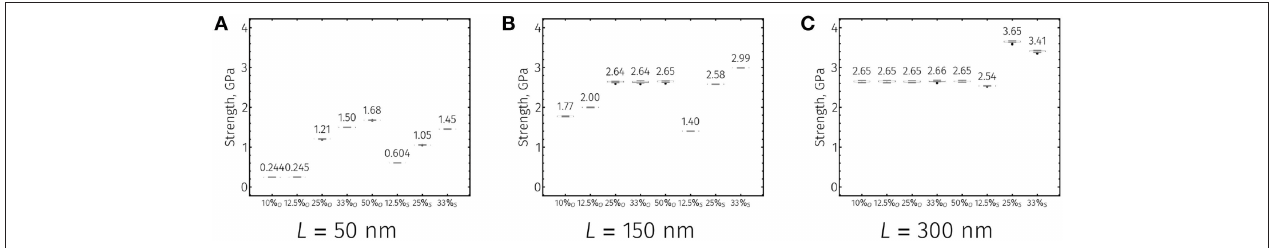
FIGURE 6 | Strength box-whisker plots (20 independent simulations for each structure) of CNC films with approximate base fiber lengths (A) L = 50nm, (B) L = 150nm, and (C) L = 300nm. Colors in each plot correspond to various fiber ordering schemes. x % O and x % S refer to regular and staggered offset structures with x % offset between neighboring fibers, respectively. White horizontal lines, colored box, gray vertical lines, and black dots indicate the median, interquantile range (IQR) between 3rd and 1st quantiles, range (of all data within ± 1.5 × IQR), and outliers (points outside the range), respectively. Numeric values of the distribution medians are listed above their respective box